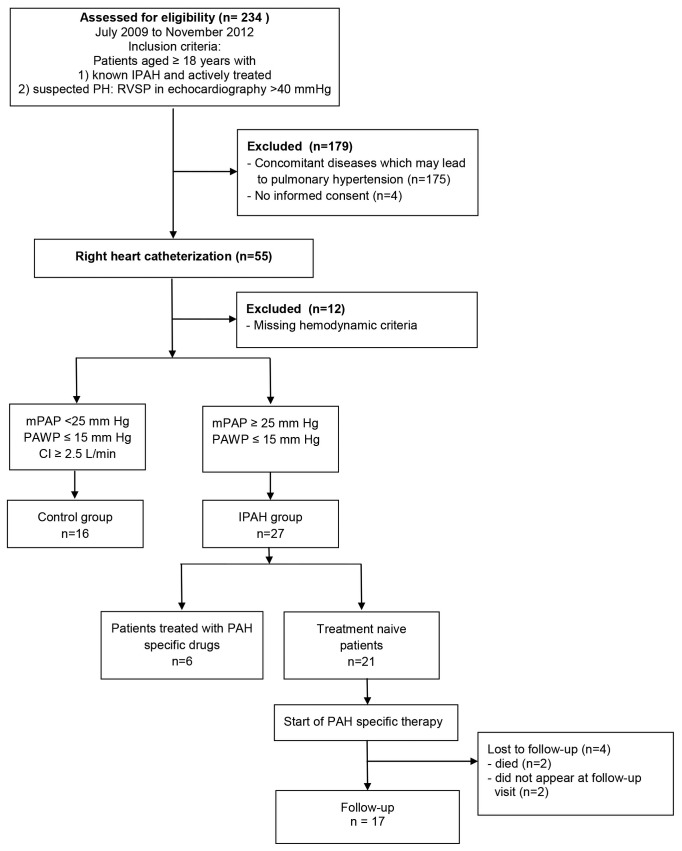
Study flow chart explaining selection of participants of the study and depicting the follow-up scenario.CI, cardiac index; IPAH, idiopathic pulmonary arterial hypertension; mPAP, mean pulmonary artery pressure; PAWP, pulmonary artery wedge pressure.